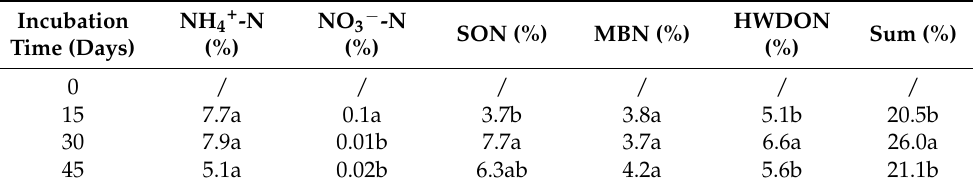
Different letters indicate the significant difference ( p < 0.05) among different incubation days.